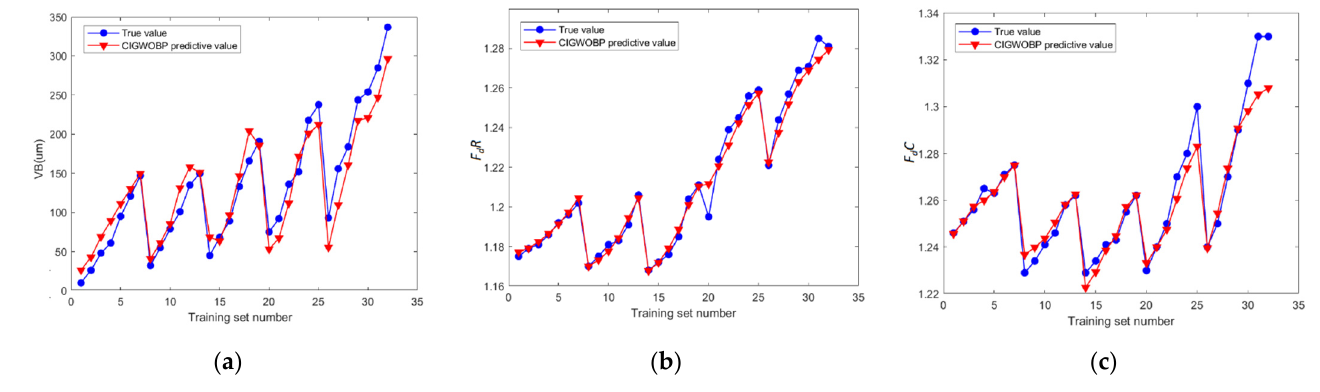
Figure 15. Training results: ( a ) VB; ( b ) F d R ; ( c ) F d C .